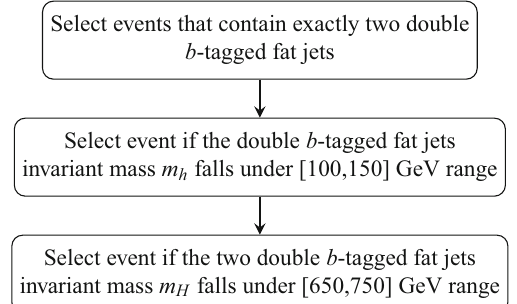
Fig. 8 Additional event selection used to compute the final signal-to- background rates